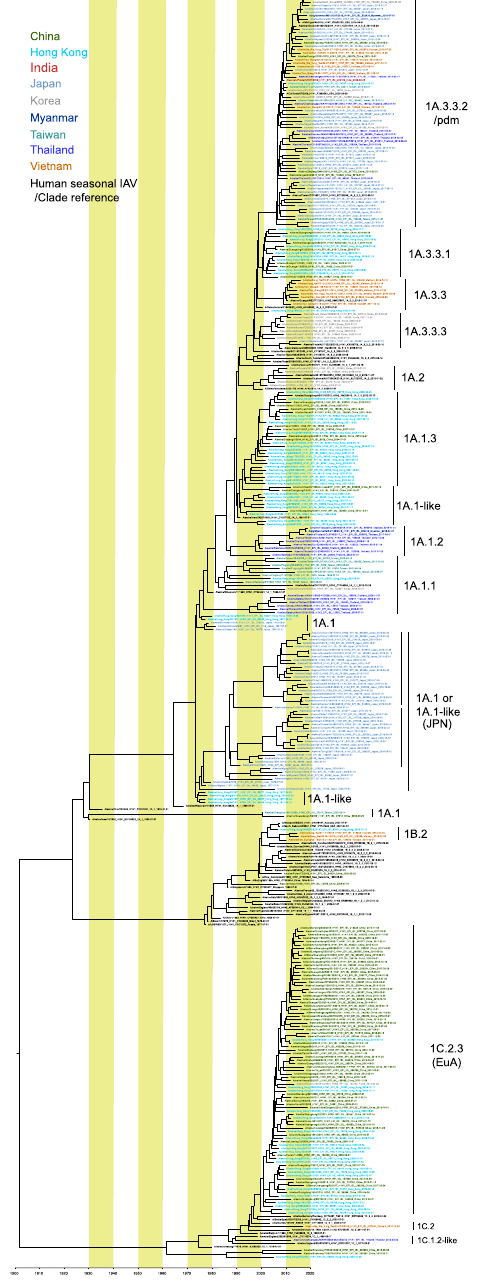
Figure 3. Maximum clade credibility (MCC) phylogenetic tree of the HA genes of Asian H1 IAVs-S. All available H1 HA gene sequences with complete HA coding regions from IAVs-S isolated in the nine Asian countries in Figure 2 were downloaded from GISAID on 8 July 2021. Sequence data from the Philippines were unavailable at the time of the download. Sequence data for each country or region underwent cd-hit clustering [69] (threshold, 98.5% identity) to reduce the number of sequences and increase visualization. ‘China’ refers to mainland China, and Hong Kong and Taiwan were considered as separate regions because they differ in pig trade and other livestock-related practices that might affect the prevalence of IAV-S. For the calculation, when only the year was available as the isolation date from GISAID, 1 July was used as the tentative isolation date; when only the year and month were available, the 15th was used as the day. This tree was constructed to illustrate the overall evolutionary pathway of Asian IAVs-S, not for precise calculation of the divergence time. Various the human seasonal IAVs and IAVs-S from other countries have been included as clade